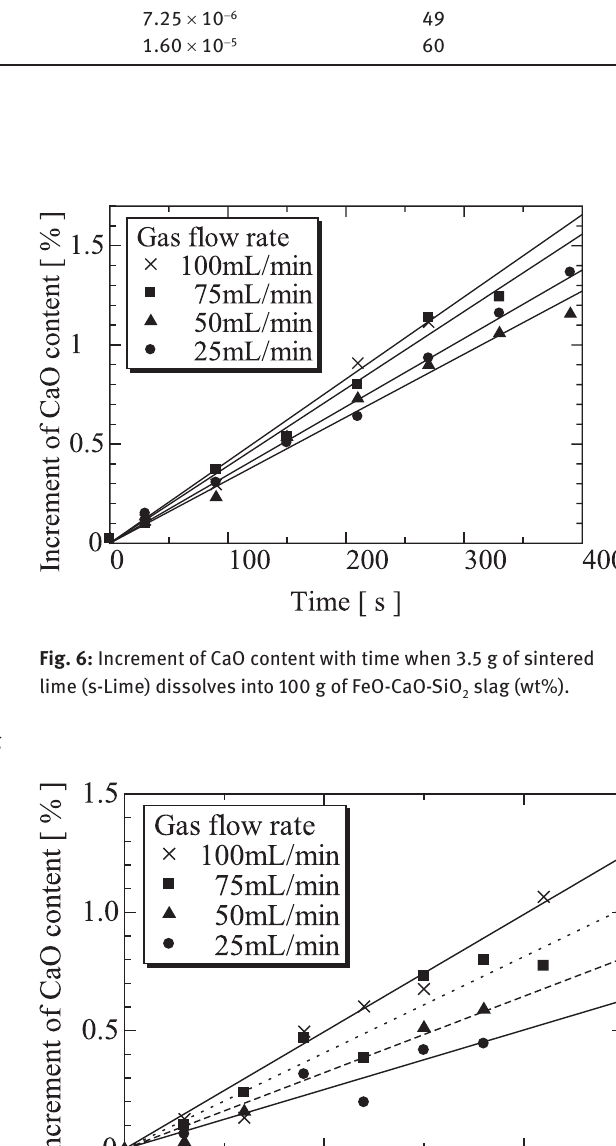
number. Figure 6 shows the increment of CaO content with time. The increment of CaO content is increased with time due to the dissolution of s-Lime. The gradient has become large with the increase in gas flow rate. Figure 7 shows the increment of CaO content with time when 3.5 g